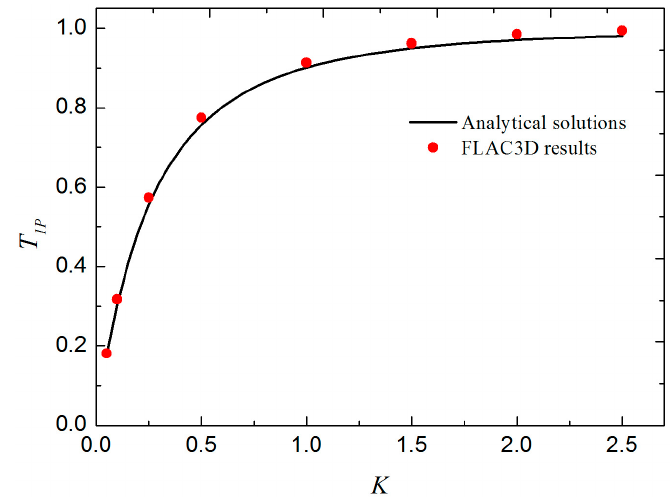
Figure 2. Relations between transmission coefficient T 1 P and normalized joint stiffness K for normally incident P wave transmission across a single joint. FLAC3D: three dimensions of the Fast Lagrangian Analysis of Continua